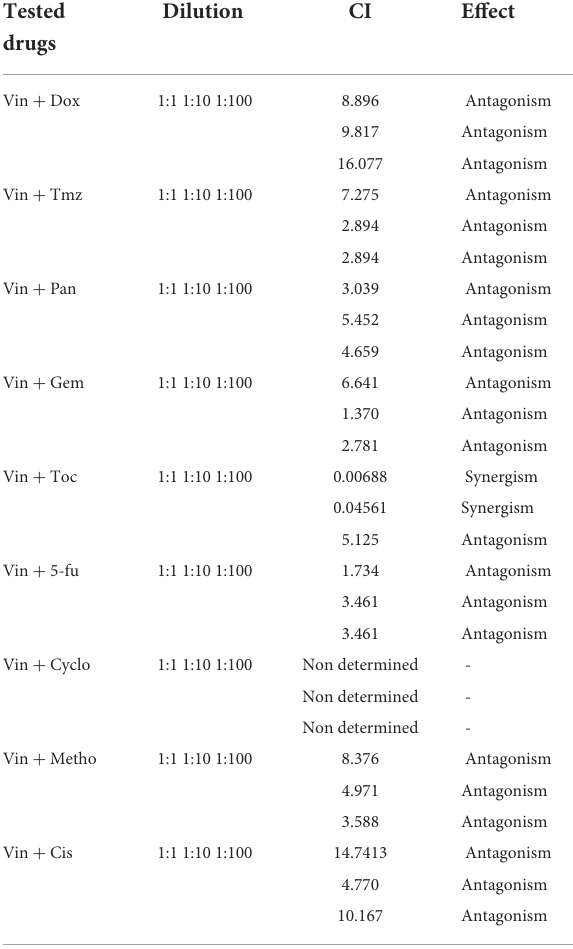
TABLE 1 Combination index (CI) values of the effect of different combinations of vincristine and other drugs on the CTVT cells viability. Tested